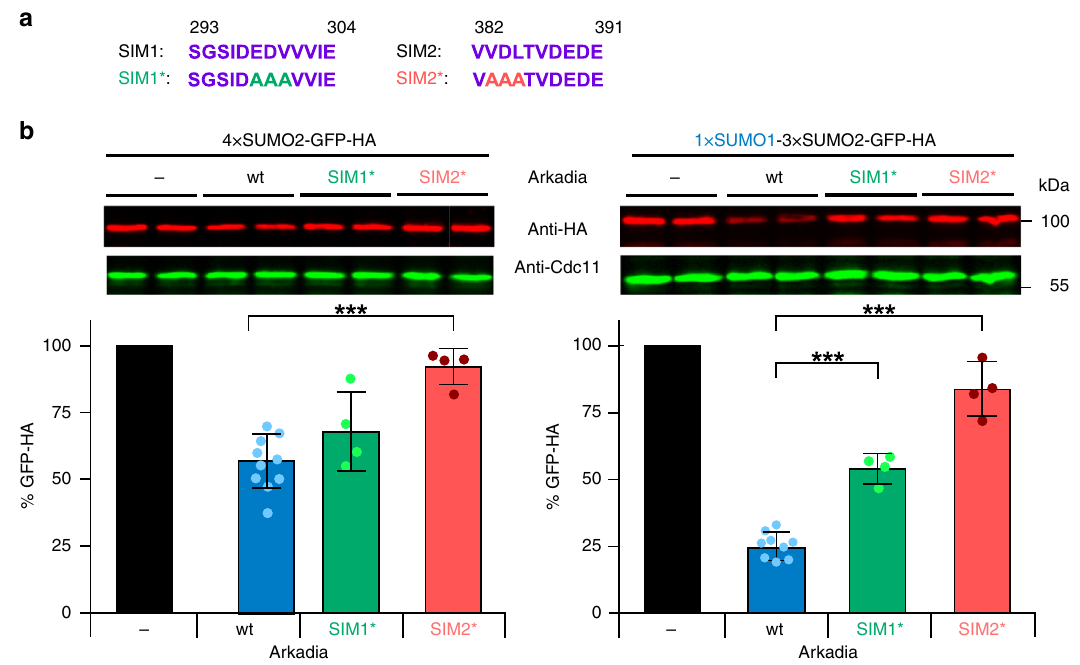
Fig. 3 Distinct roles of SIMs in substrate recognition. a Depiction of Arkadia SIM sequences and their mutant version (SIM*). The residues that were replaced by Ala residues are highlighted in red or green. b Comparison of targeting ef fi ciencies of the same substrates as in Figs. 1 and 2 by wild-type Arkadia and its SIM mutant derivatives. The analysis was carried out as described in Fig. 1c. Bars represent the means. Standard deviations (SD) are indicated by error bars. Quanti fi cations are derived from experiments with 9 independent transformants for wild-type Arkadia (same as in Fig. 1c) and four independent transformants for its SIM* mutant versions. Three asterisks indicate signi fi cant differences with p -values < 0.001. Statistical signi fi cance was determined with unpaired and two-sided Student ’ s t -tests. Source data are provided as a Source Data fi